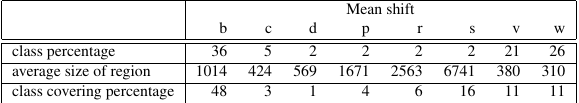
Table 2: Statistics of the percentage of each class label, the av- erage size of the region of each class, and the percentage of the image covered by each class for the baseline mean shift segmen- tation on the eTRIMS 8-class dataset. (b = building , c = car , d = door , p = pavement , r = road , s = sky , v = vegetation , w = window , same for all the following tables and figures.)